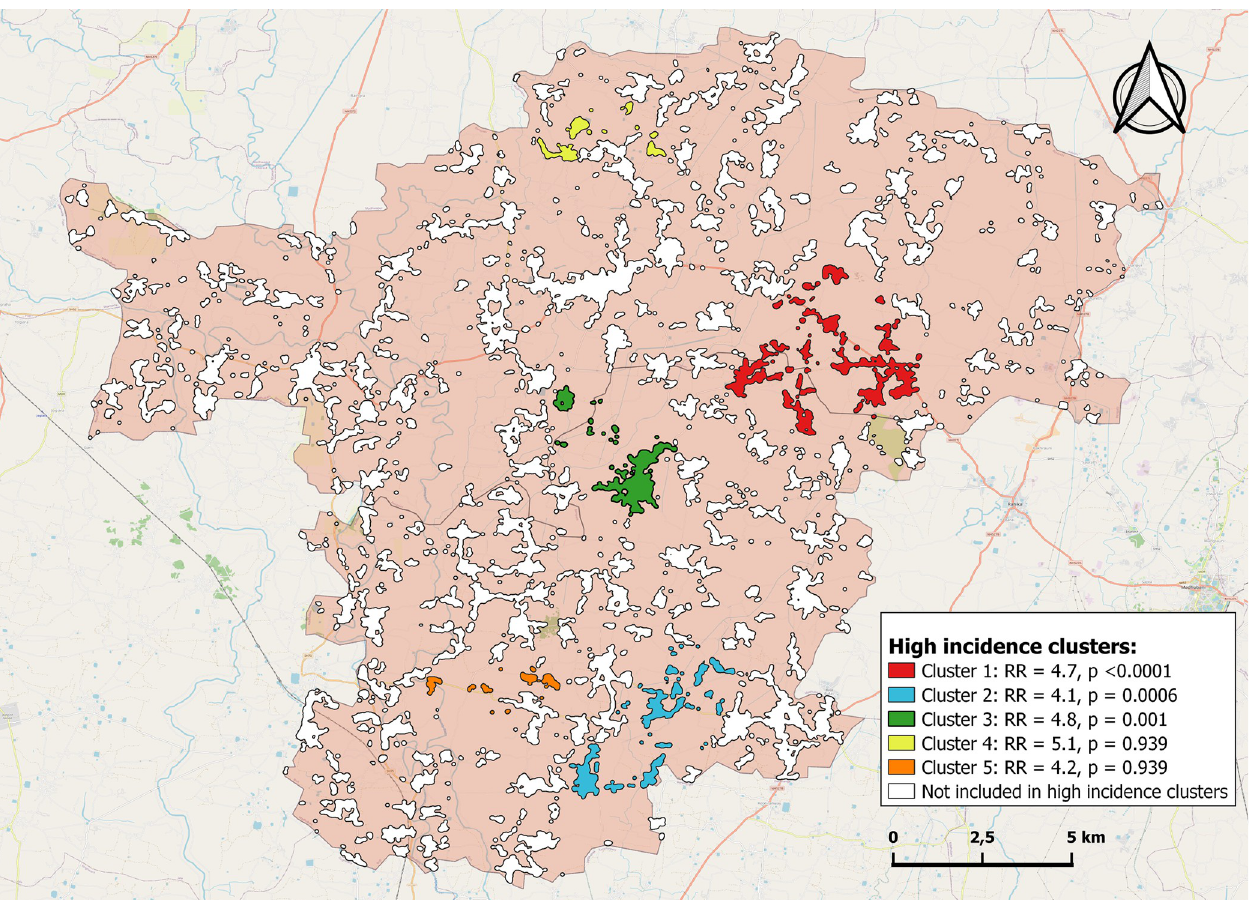
Fig 2. High incidence clusters identified, Benipatti and Bisfi, India, 2020–2022. We used OpenStreet Map as a base layer for this map (https://www. openstreetmap.org/#map=8/50.510/4.475).